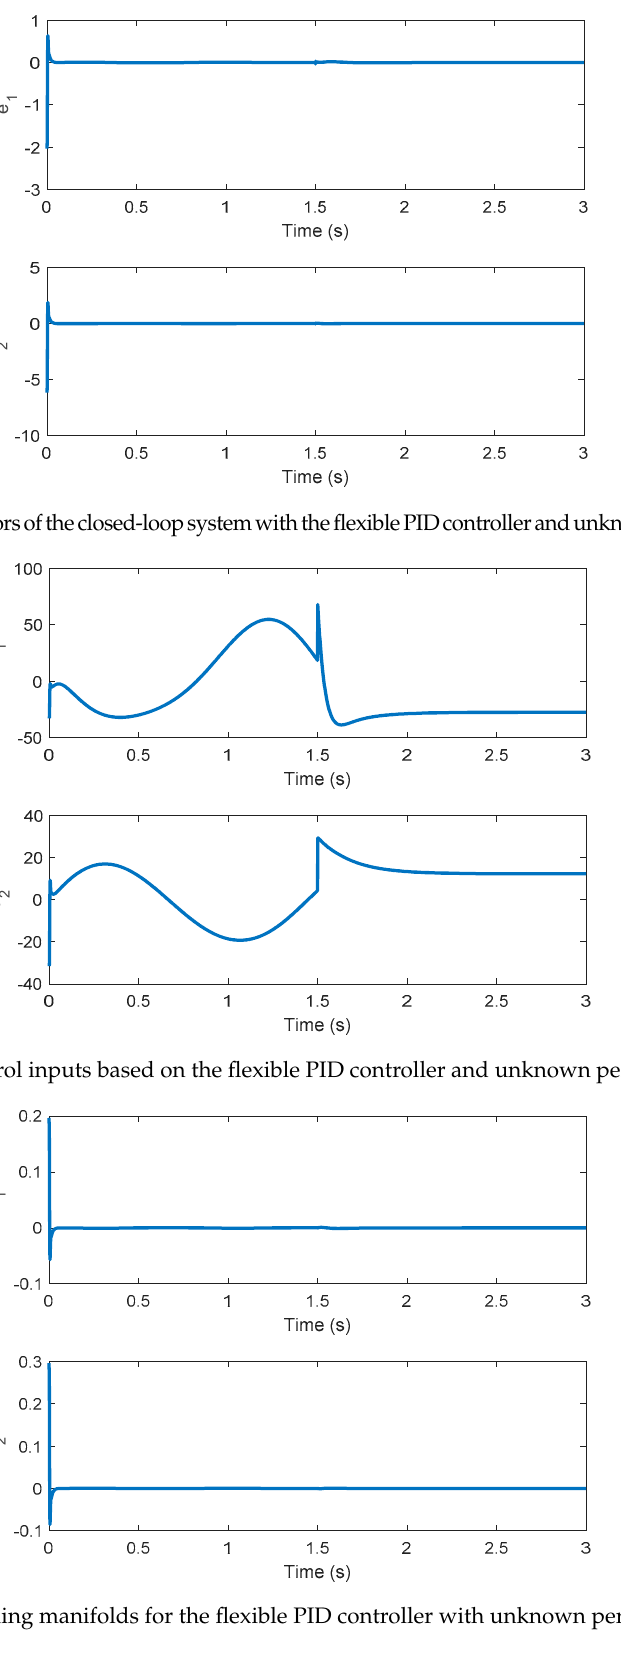
Figure 10. Sliding manifolds for the flexible PID controller with unknown perturbation.